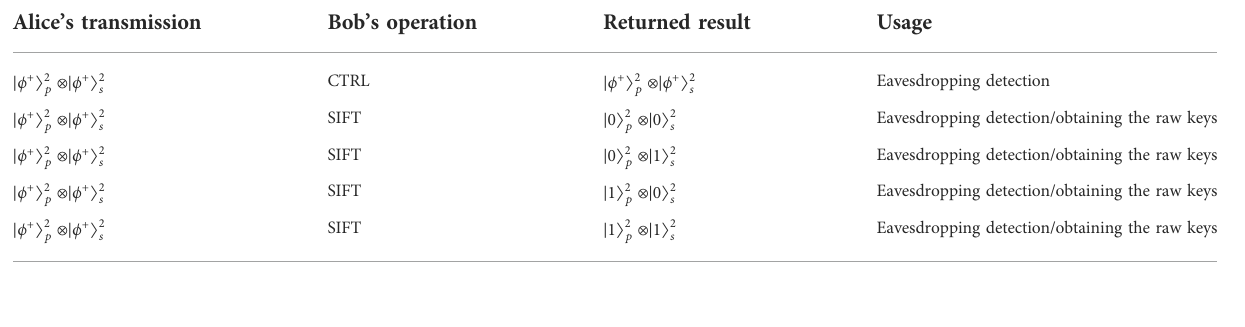
TABLE 1 One example description of Alice ’ s and Bob ’ s operations.